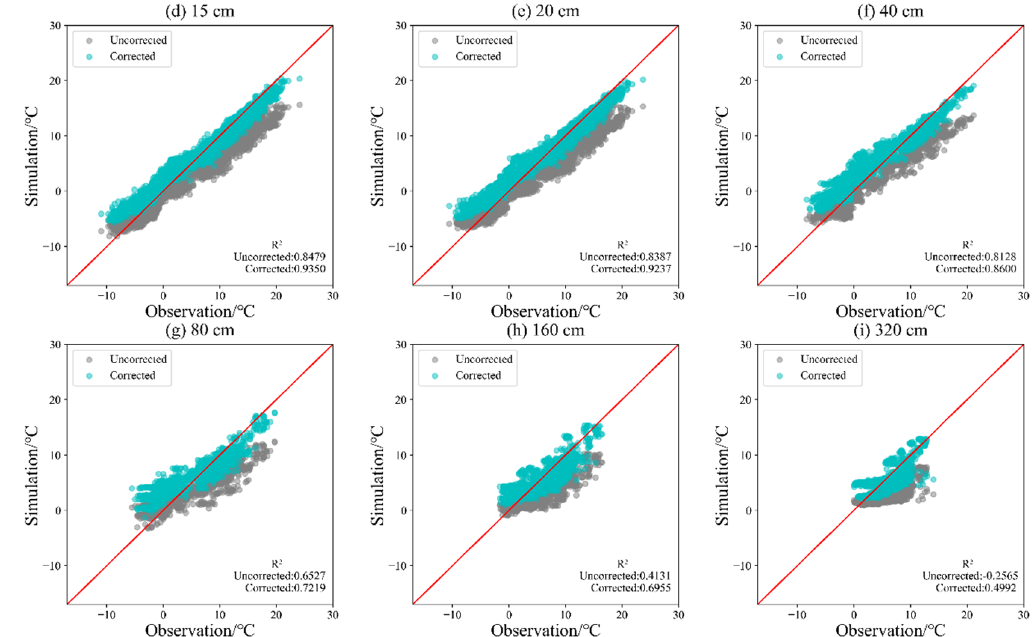
Figure 3. Comparison of simulated values and observed values at ( a ) 0 cm, ( b ) 5 cm, ( c ) 10 cm, ( d ) 15 cm, ( e ) 20 cm, ( f ) 40 cm, ( g ) 80 cm, ( h ) 160 cm, ( i ) 320 cm.